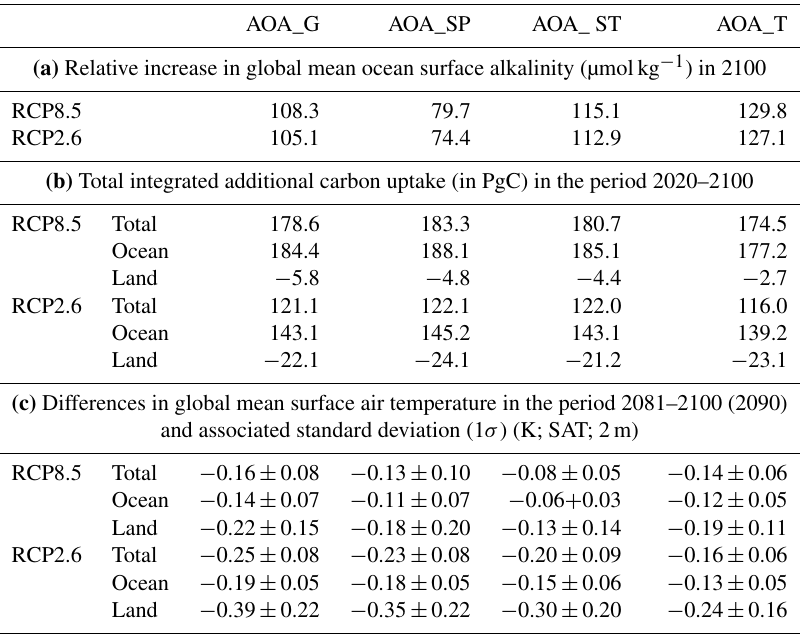
Table 1. For the two RCP scenarios: (a) the relative increase in global mean ocean surface alkalinity (µmolkg − 1 ) between each AOA experiment and control experiment in 2100; (b) the total integrated additional carbon uptake (in PgC) in the period 2020–2100 in different experiment and emissions scenarios, positive denotes enhanced uptake; (c) the differences in global mean surface air temperature in the period 2081–2100 (2090) and associated standard deviation (1 σ ) (K; SAT; 2m) for the four different AOA experiments for each emission scenario, relative to the same emission scenario with no